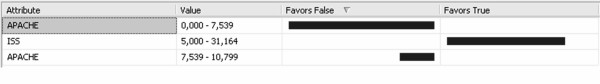
The LRM results.